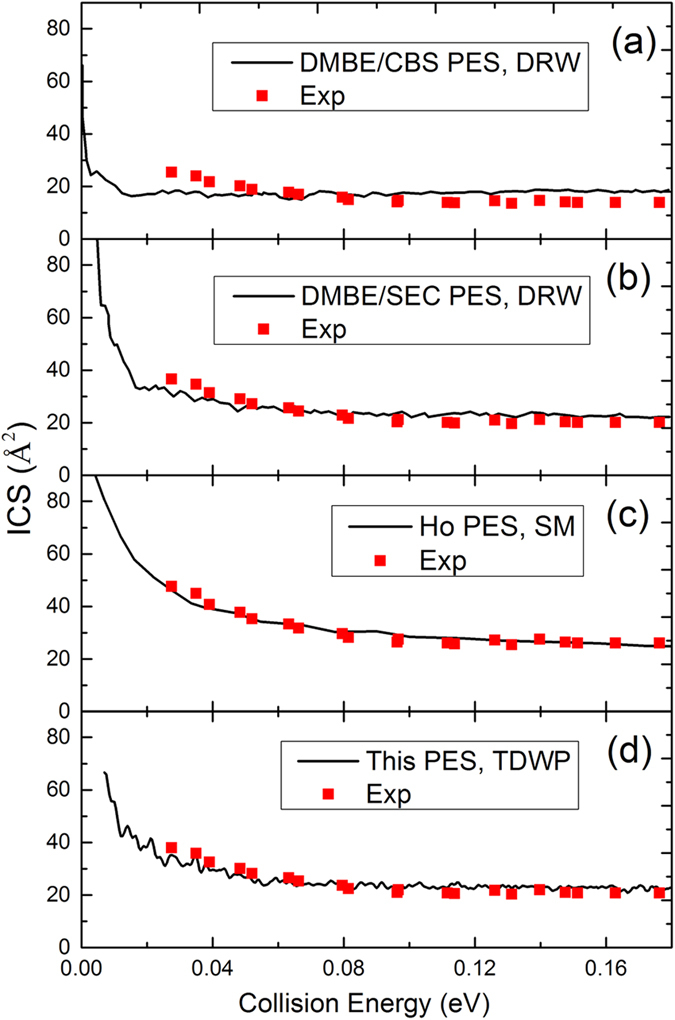
The theoretical ICSs of the S(1D) + H2(X1Σg+) → H(2S) + SH(X2Π) reaction compared with the experimental data4.The previous theoretical results include the ICSs20 calculated using the DRW code on DMBE/CBS PES (a) and DMBE/SEC PES (b) and ICSs21 obtained from SM calculations employing the Ho PES (c). Our results (d) were obtained using the TDWP method on the new PES. The experimental results have been scaled to match each of the theoretical results. The scale coefficient minimizes the RMSE between the experimental data and the corresponding theoretical results.